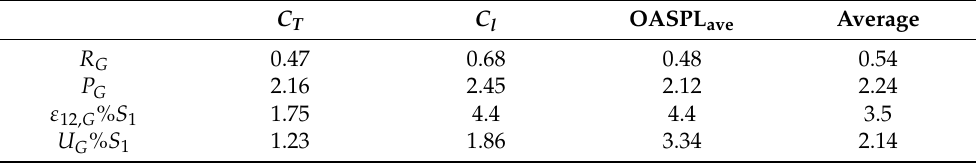
Table 6. Grid verification of CRC-3 at θ = 0 ◦ , RPM = 12,000, and U 0 = 16